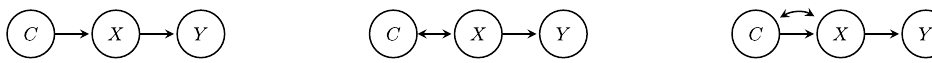
Figure 1: All ADMGs that form an LCD triple C X Y , , ( ) , assuming d - faithfulness. In the absence of latent confounders and selection bias, the structure can only be that of the DAG on the